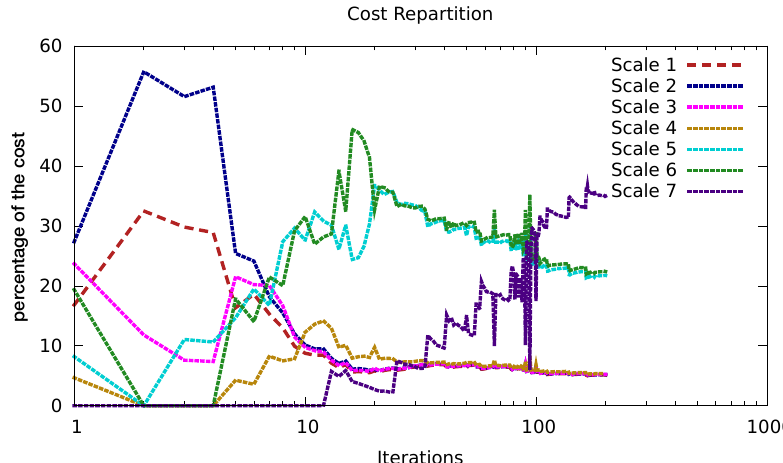
Figure 12. Contribution to the observation cost function, in percentage, of each activated scale, as a function of the minimisation iterations. The coarsest scale is the first one, the finest scale is the